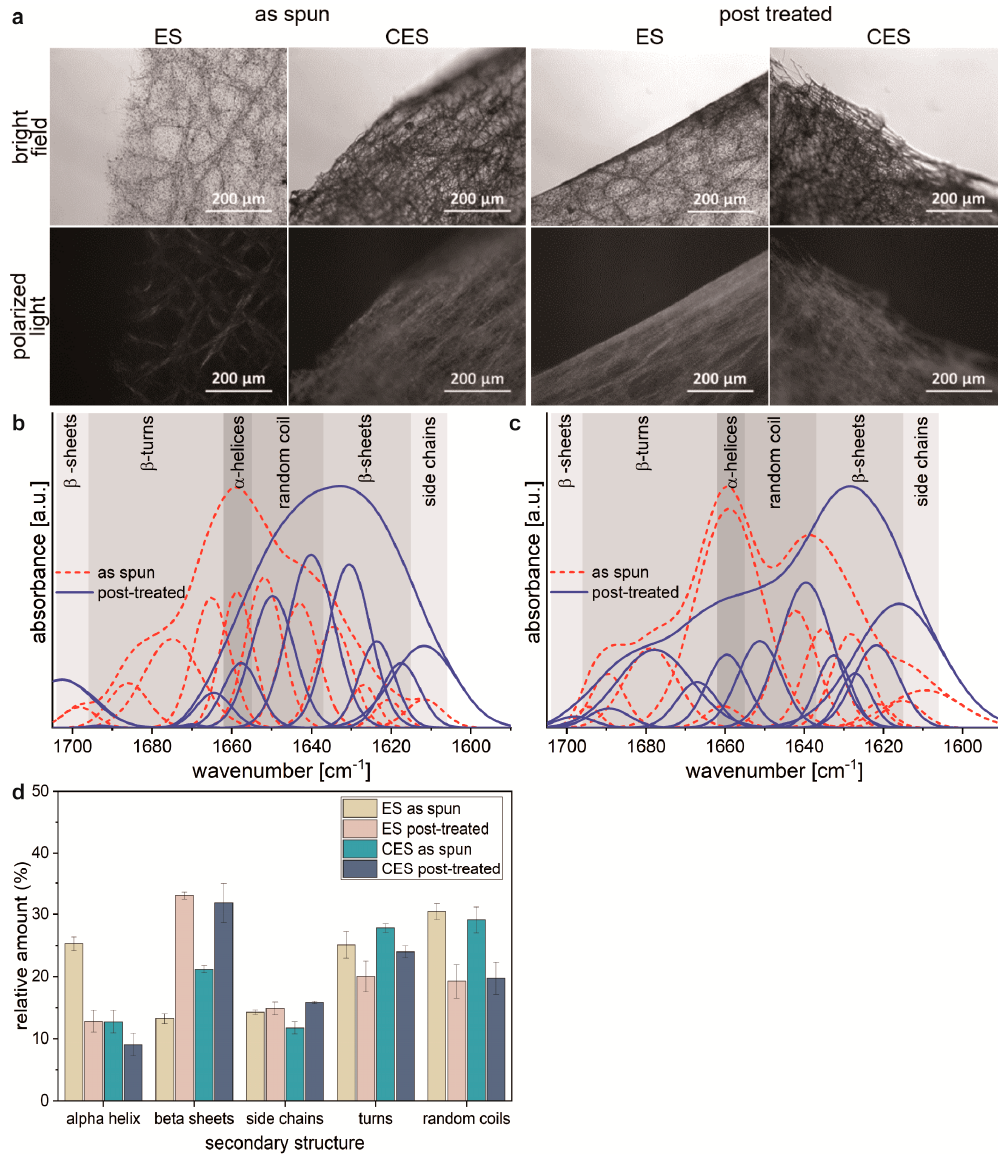
Figure 2. Effect of spinning method on β -sheet content of produced spider silk fibers. ( a ) Comparison of bright field and birefringence images of needle electrostatic spun (ES) and centrifugal electrospun (CES) spider silk fiber meshes as-spun and after ethanol vapor treatment (post-treatment). As-spun CES fibers showed birefringence even without post-treatment. Comparison of normalized FTIR spectra including deconvolution of needle electrospun ( b ) and centrifugal electrospun ( c ) silk protein fiber meshes as spun and after ethanol vapor post-treatment. ( d ) Secondary structure elements as determined using FTIR analysis of needle electrospun (ES) and centrifugal electrospun (CES) silk protein fiber meshes before (as-spun) and after post-treatment.